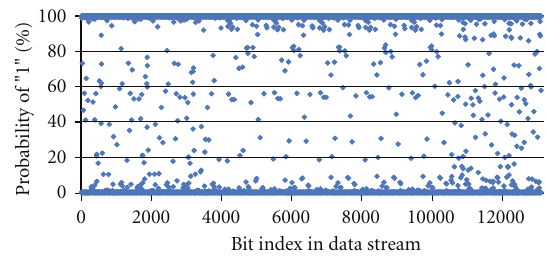
Figure 1: Probability of bit value “1” over 10 k measurements on device D.